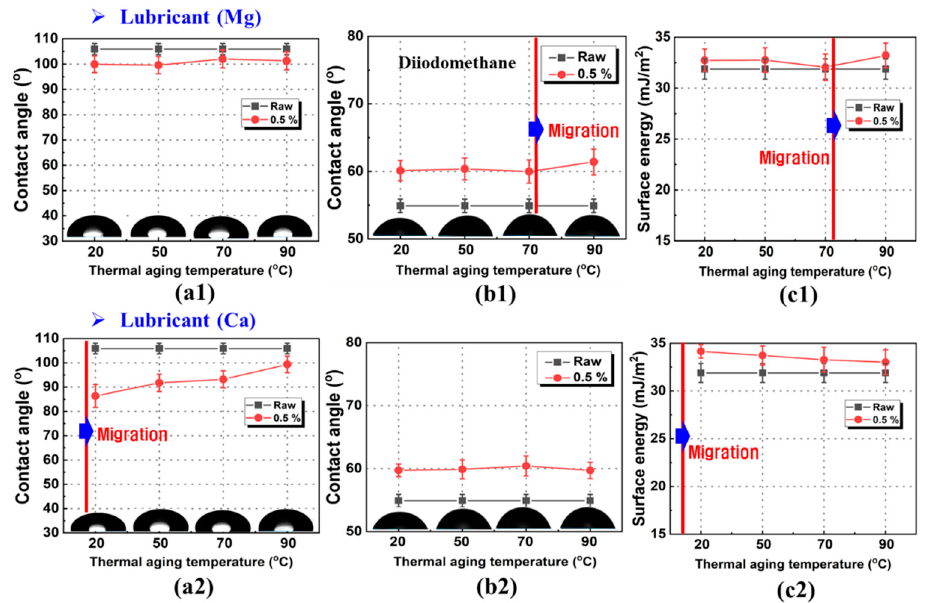
Figure 3. Variation in contact angles and surface energies of Polypropylene/lubricant composites aged at different temperatures at a humidity of 100% relative to different test liquids: ( a ) Distilled water, ( b ) diiodomethane, and ( c ) surface energy.